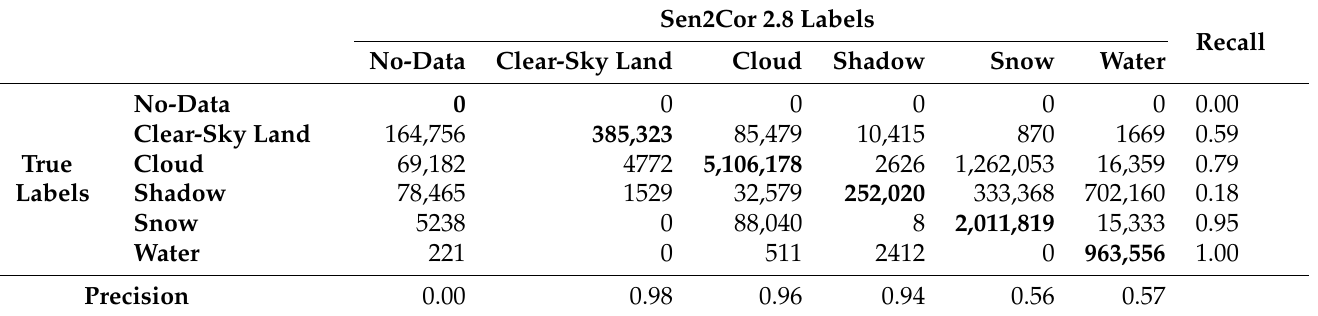
Table 6. Confusion matrix comparing the predictions of Sen2Cor 2.8 with the true labels in the test dataset.